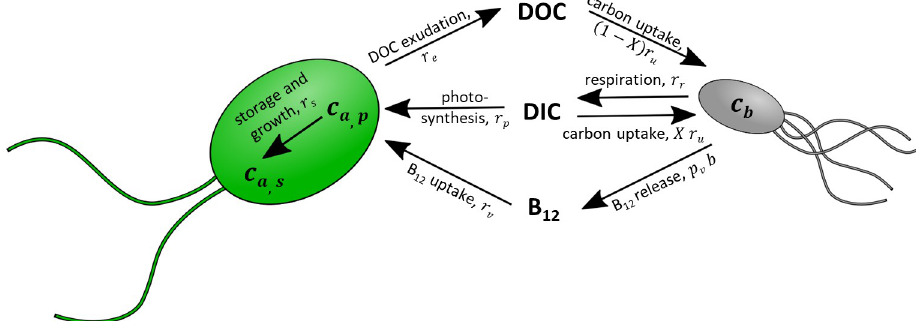
Fig 1. Schematic to illustrate the nutrient kinetics included in the algal-bacterial co-culture model. Vitamin B 12 is released by bacteria and required for algal growth. Bacterial growth is dependent on DOC produced by algae. Also considered are: algal photosynthesis, carbon storage, and DOC exudation from excess photosynthesis; bacterial respiration and DIC